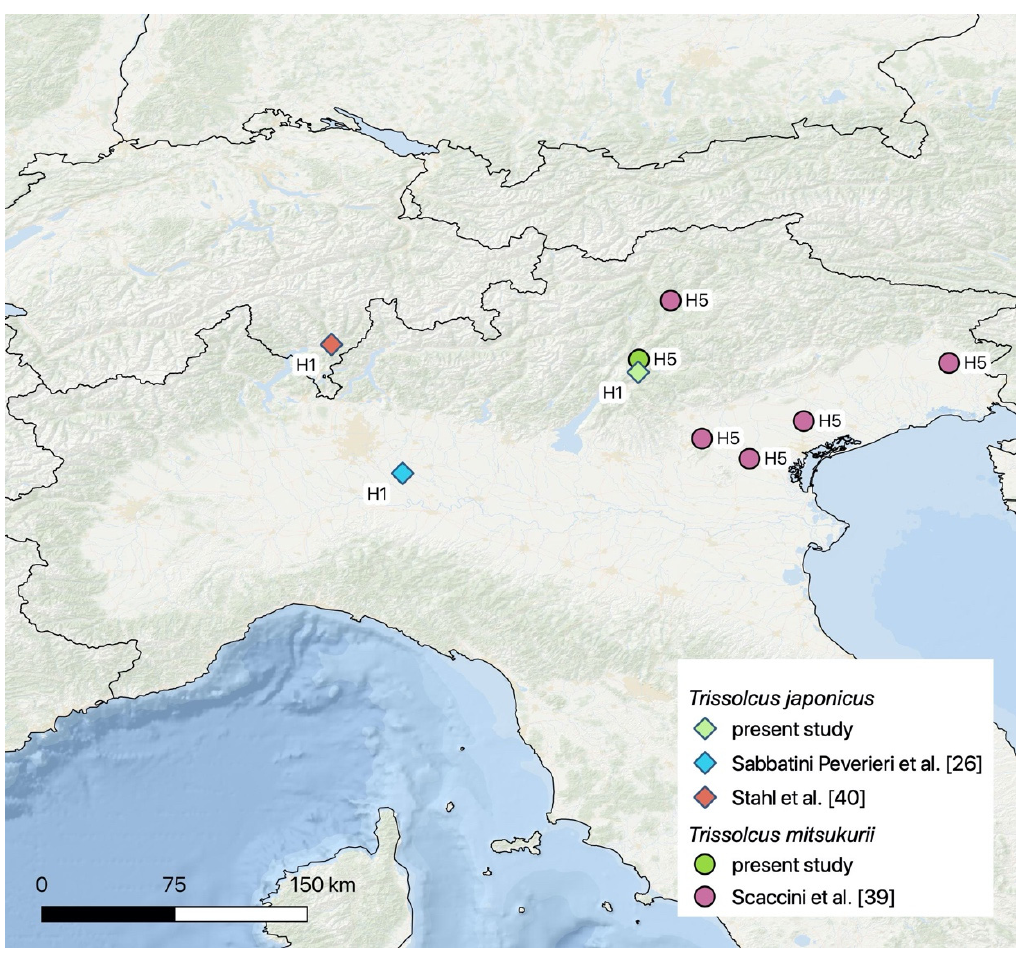
Figure 4. Current distribution of Trissolcus japonicus (diamonds) and Trissolcus mitsukurii (circles) haplotypes, showing records from the present study and adapted from Sabbatini Peverieri et al. [26], Scaccini et al. [39], and Stahl et al. [16].